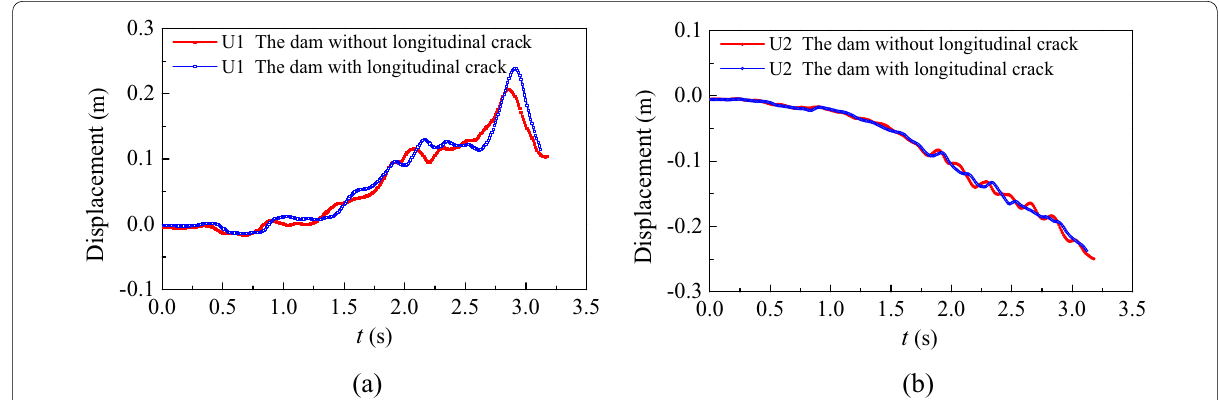
Fig. 28 Comparisons of ( a ) horizontal displacement and ( b ) vertical displacement responses of two gravity dam